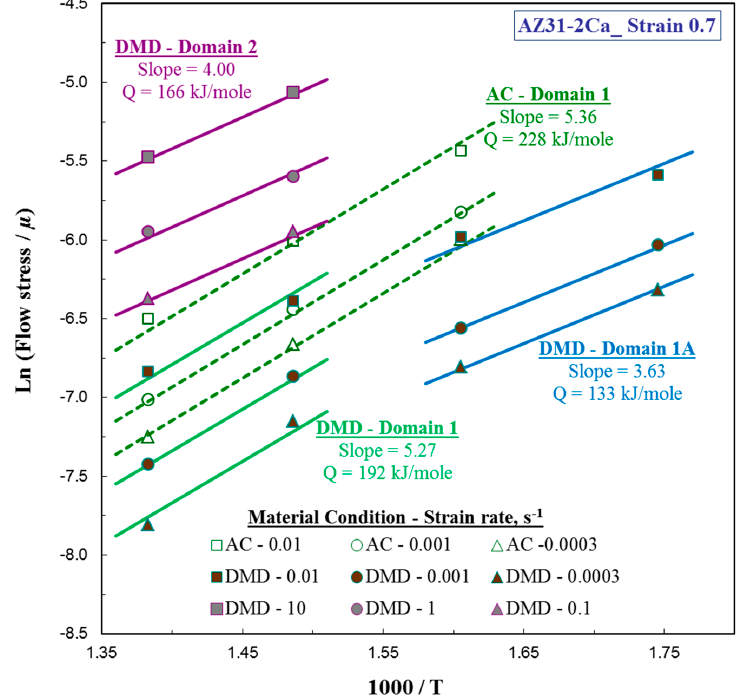
Figure 13. Arrhenius plots obtained on AZ31-2Ca in the processing domains of DMD processed against as-cast alloy.